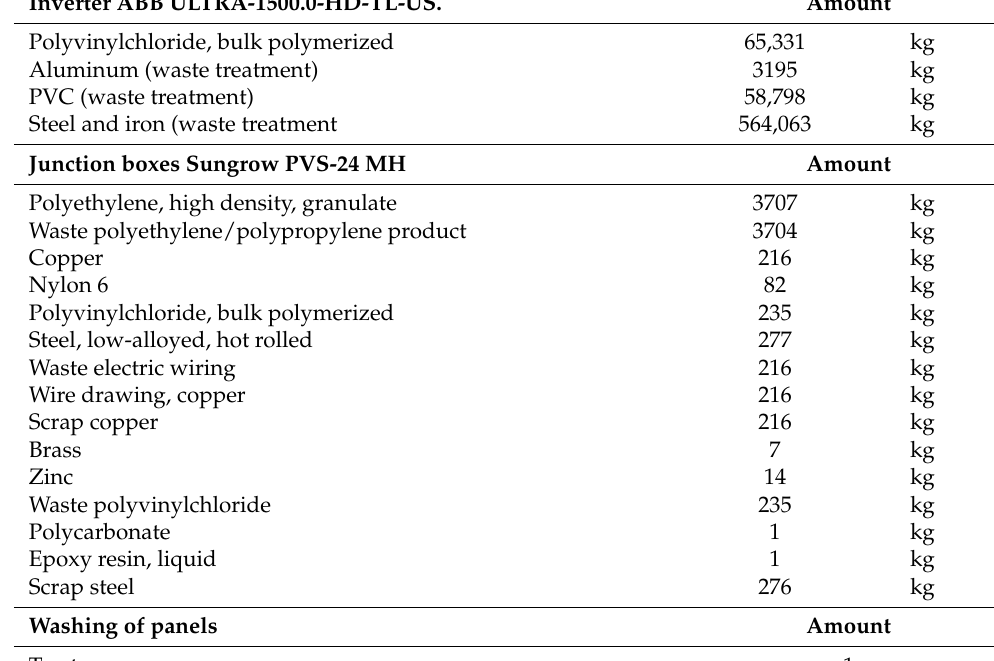
Table A2. Cont. Inverter ABB